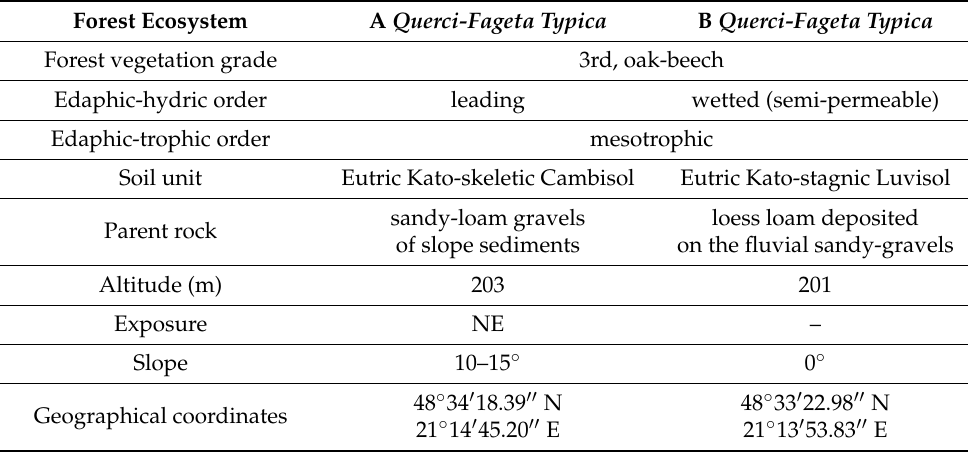
Table 1. General geobiocoenological characteristics of forest ecosystems.